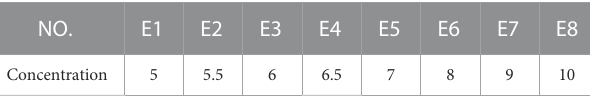
TABLE 5 Concentration of EDTA-2Na solution (%).